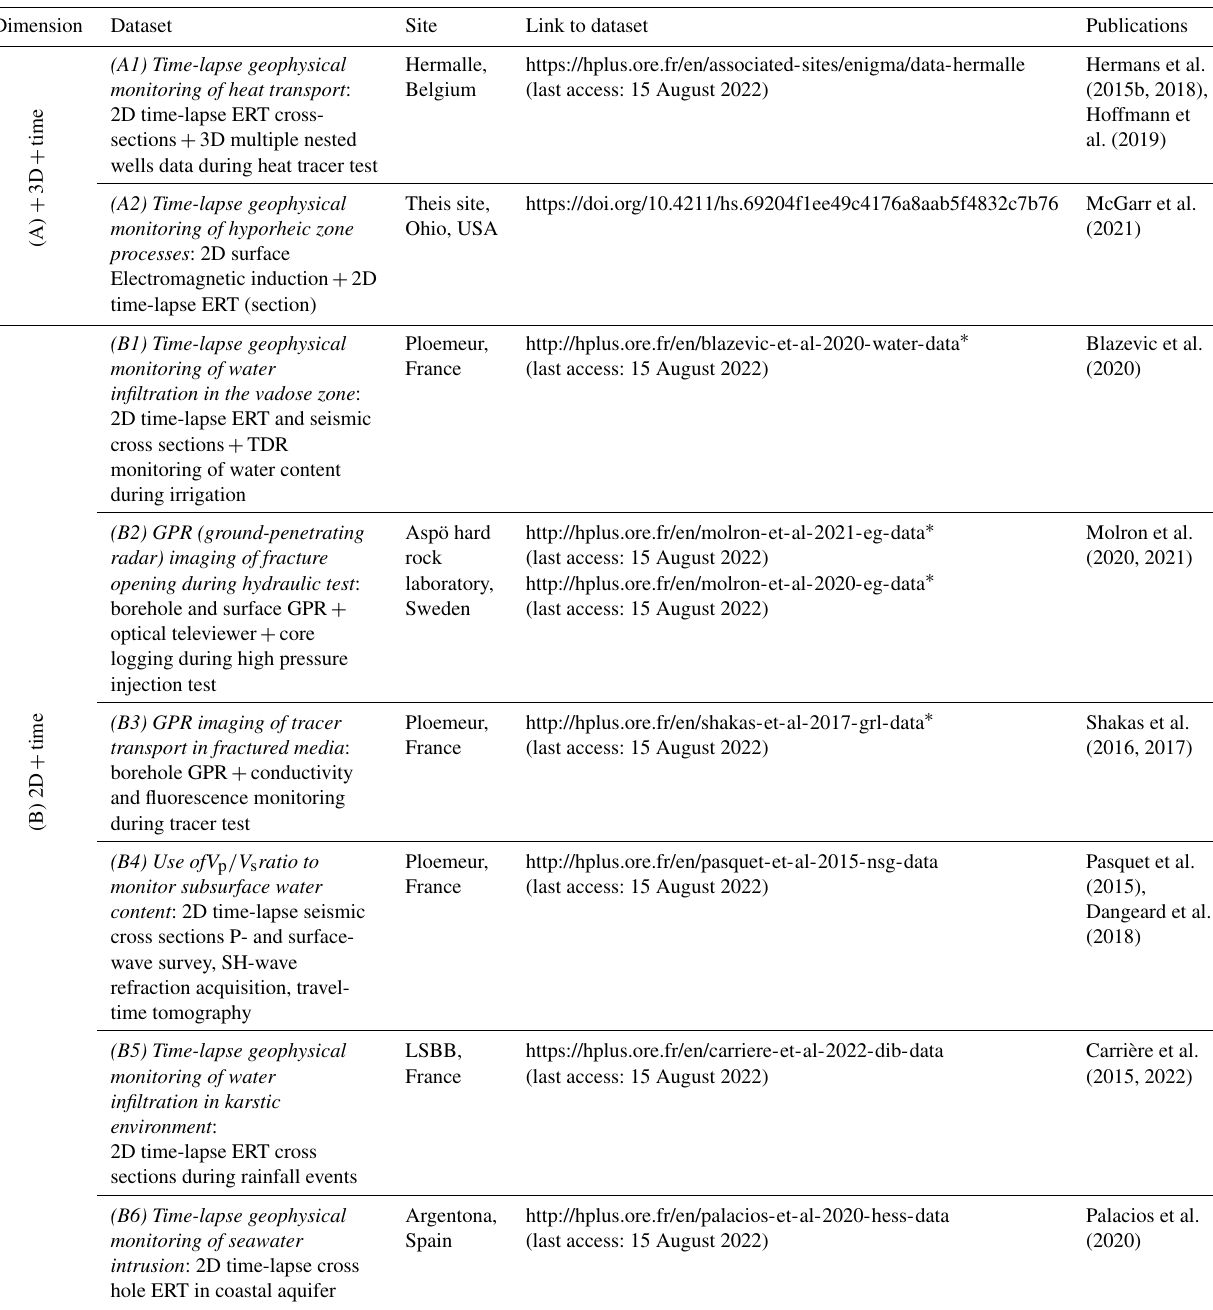
Table 2. Selection of datasets available online for multidimensional hydrogeological system characterization and monitoring. Datasets were selected based on their online availability, their link with a dynamic component of the subsurface, and their relevance for illustrating the paper. This table will be available online at https://hplus.ore.fr/en/database/4d-hydrogeology-dataset (last access: 15 August 2022), with the possibility to contribute to enrich the datasets with new